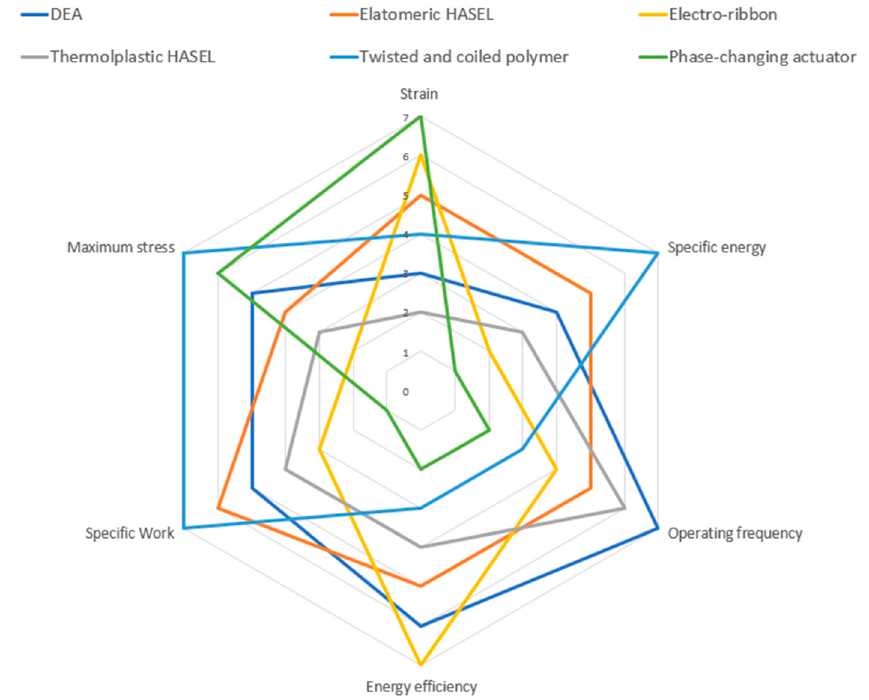
Figure 10. Qualitative comparison of the key parameters of each type of actuator. The rating number (0–6) was assigned based on the ranking of the higher end of the typical performance (shown in Table 2) of each type of actuator. A rating of 2 means the poorest performing type of actuator, while a rating of 7 means the best. A rating of 1 means that the we could not find any reported value of the parameter for that type of actuator.